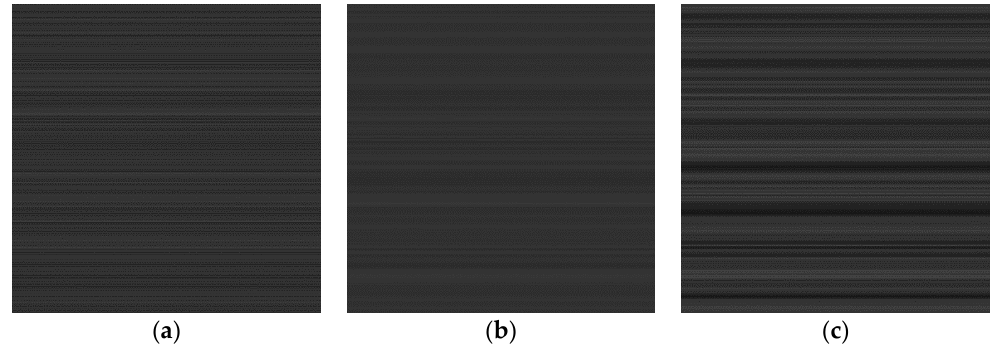
Figure 12. Correction result image of the evaluation image of Figure 10a with the steady ‐ mode output of various ICS radiation. ( a ) steady ‐ mode ICS ‐ 1000; ( b ) steady ‐ mode ICS ‐ 3000; ( c ) steady ‐ mode ICS ‐ 5000.